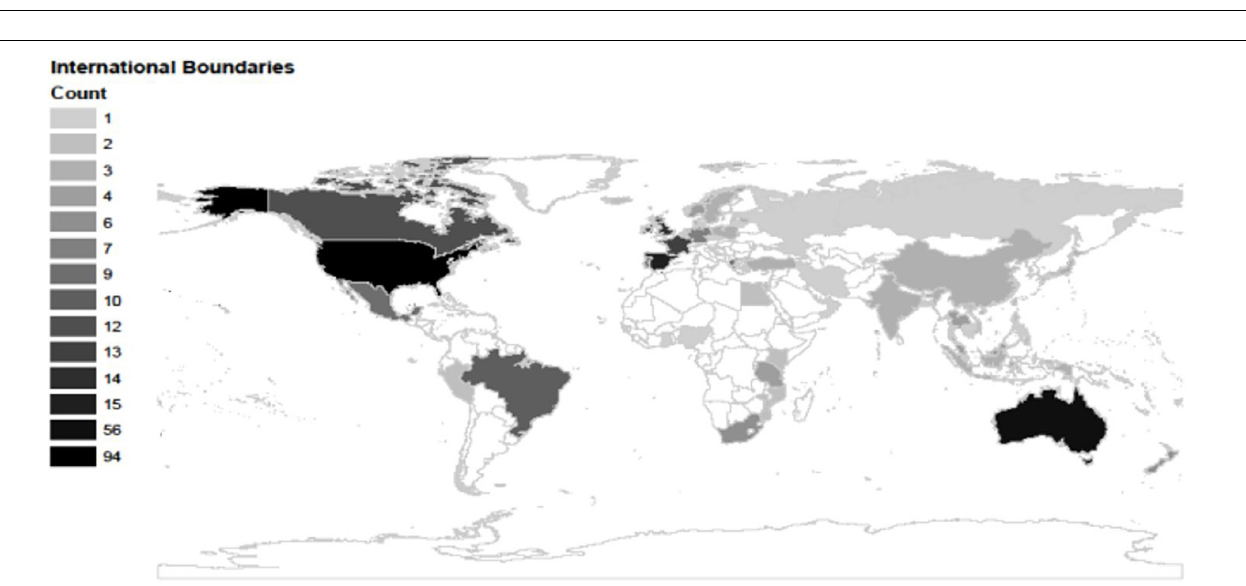
FIGURE 2 | Map showing number of ocean perceptions studies per country ( n =